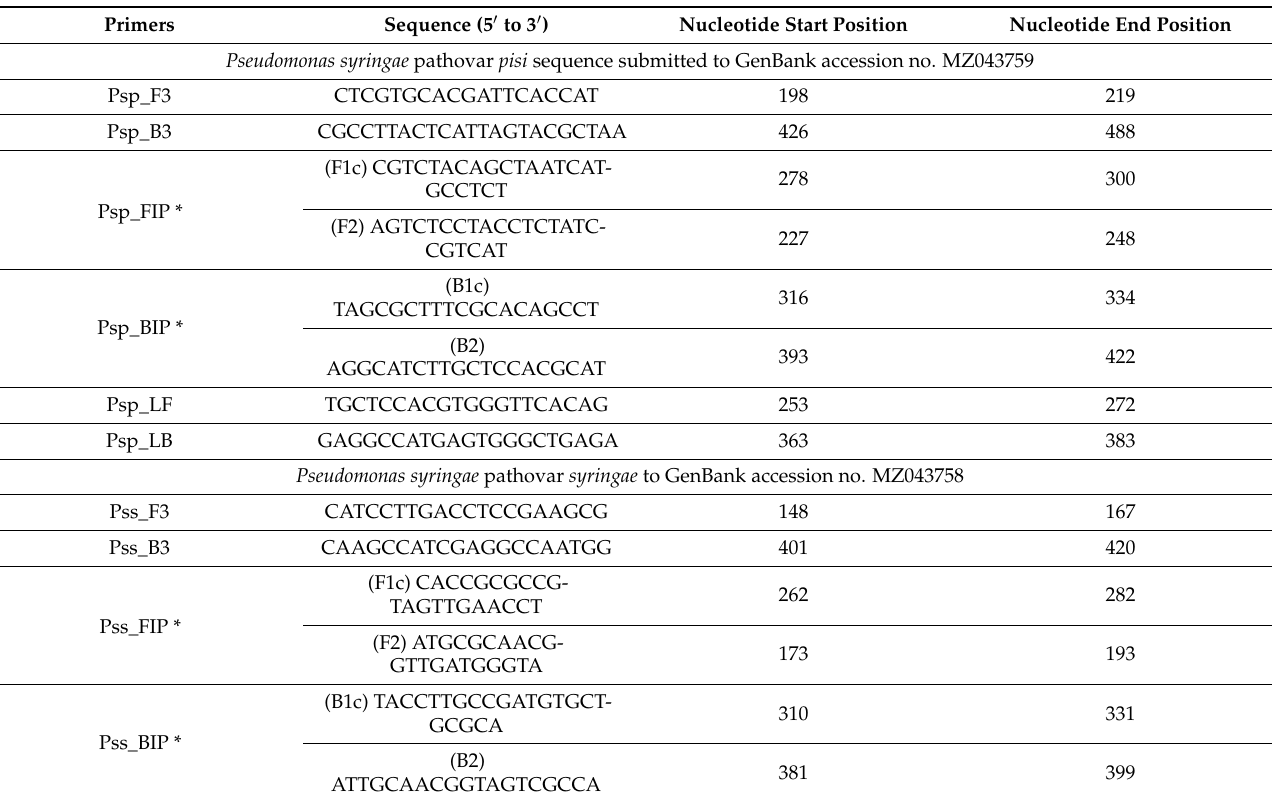
Table 2. Details of LAMP primers for Pseudomonas syringae pathovar pisi and Pseudomonas syringae pathovar syringae . Primers Sequence (5 (cid:48) to 3 (cid:48) ) Nucleotide Start Position Nucleotide End